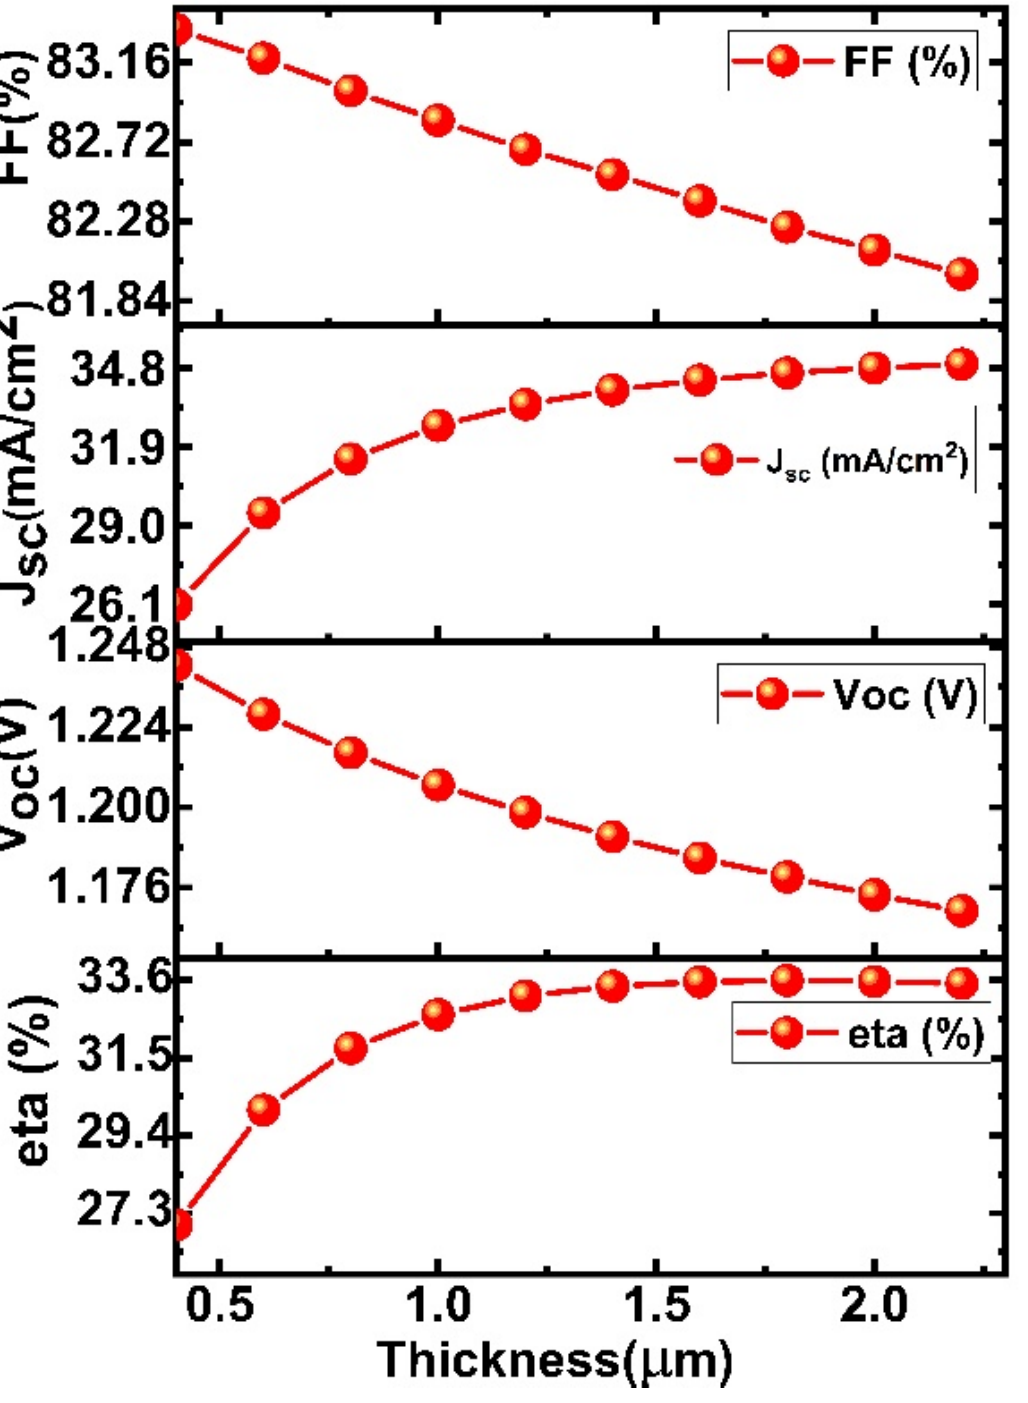
Figure 2. Effect of the perovskite layer thickness on solar cell parameters (J sc , V oc , FF, and η ].